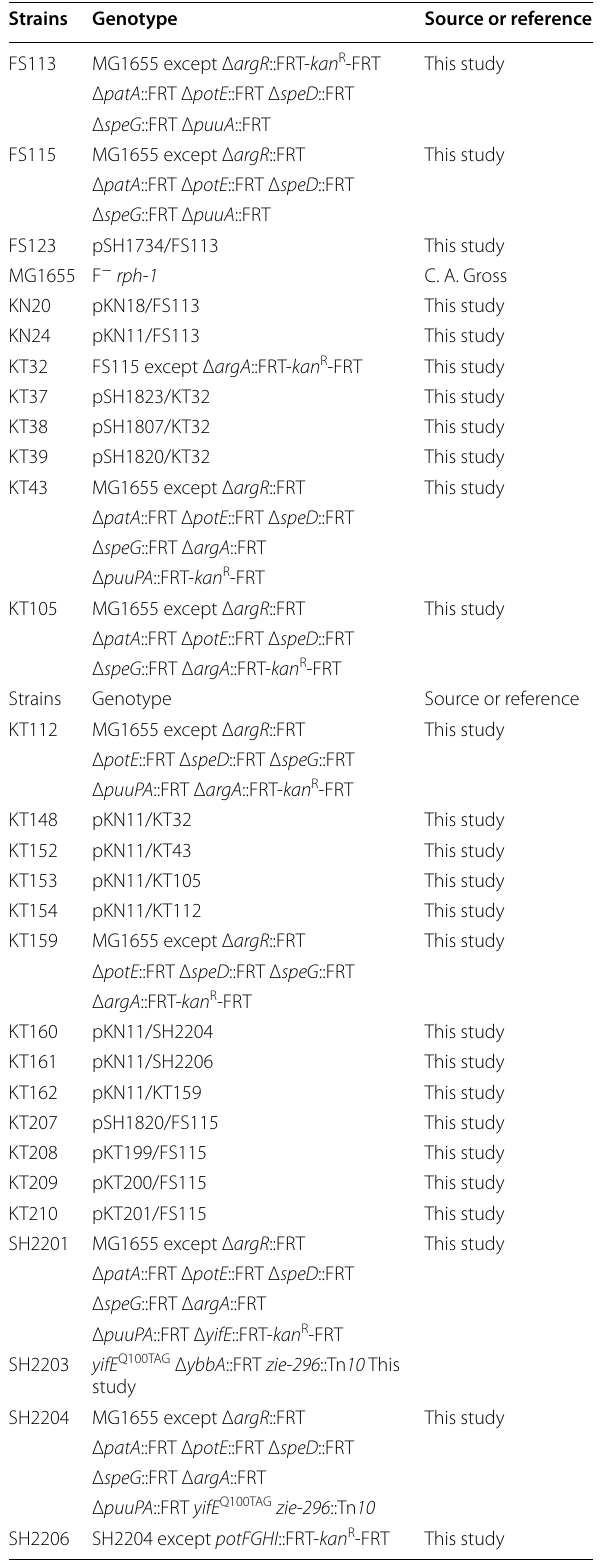
Table 1 Strains used in this study Strains Genotype Source or